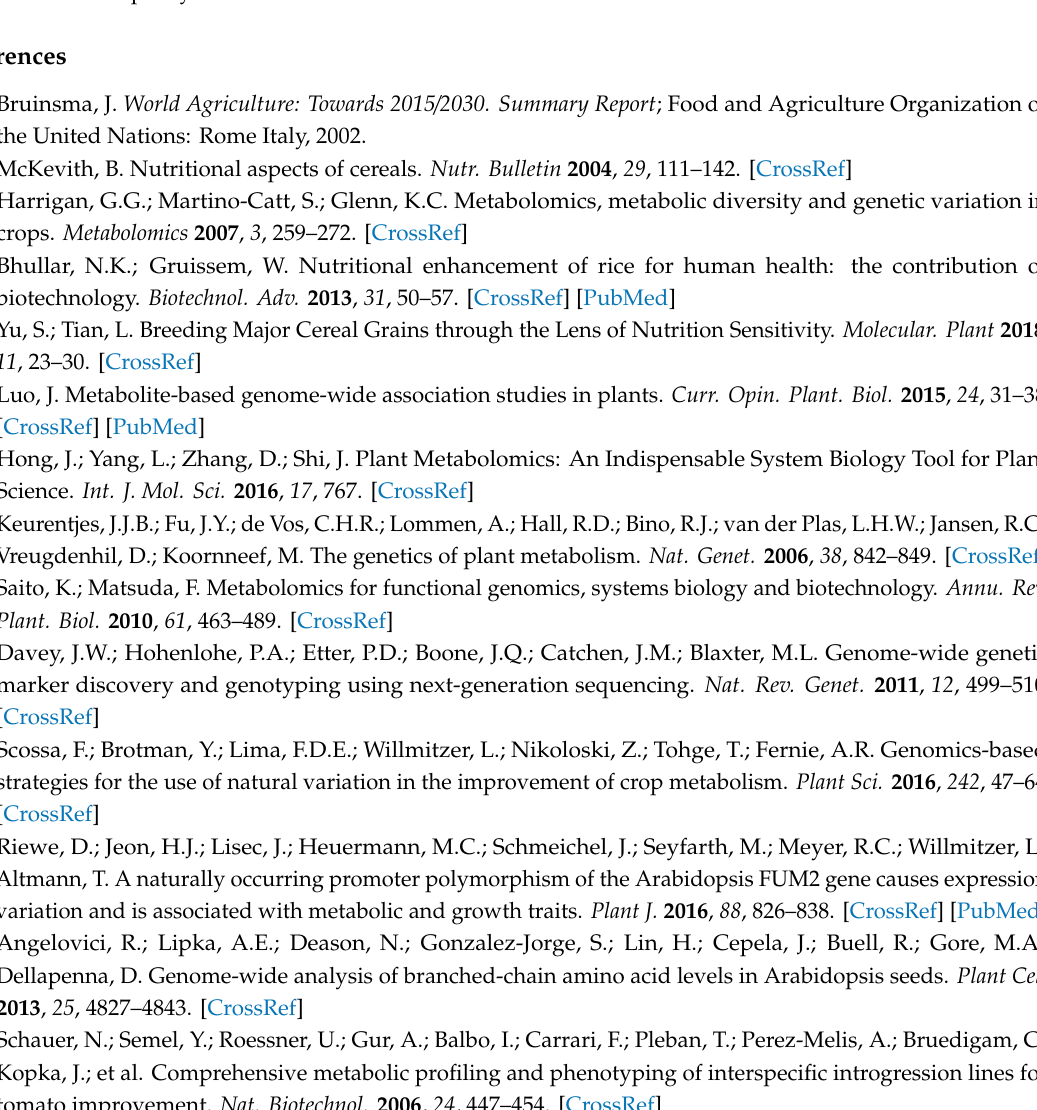
Table S2. Metabolome profiles of the 183 metabolites measured by widely-targeted metabolome analysis in seeds grains of the forty B. distachyon inbred lines. Supplementary Table S3. Metabolome profiles of the thirty-seven metabolites measured by widely-targeted metabolome analysis in seed grains of the B. distachyon Bd3-1 × Bd21 RILs. Supplementary Table S4. Genes annotated in the QTL region of 4-Pyridoxate content. Supplementary Table S5. Genes annotated in the QTL region of chrysanthemin